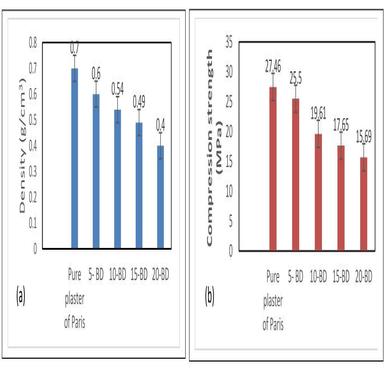
Physico-chemical properties (a) density (b) compression strength, (c) water absorption, (d) thermal conductivity, and (e) tensile strength.